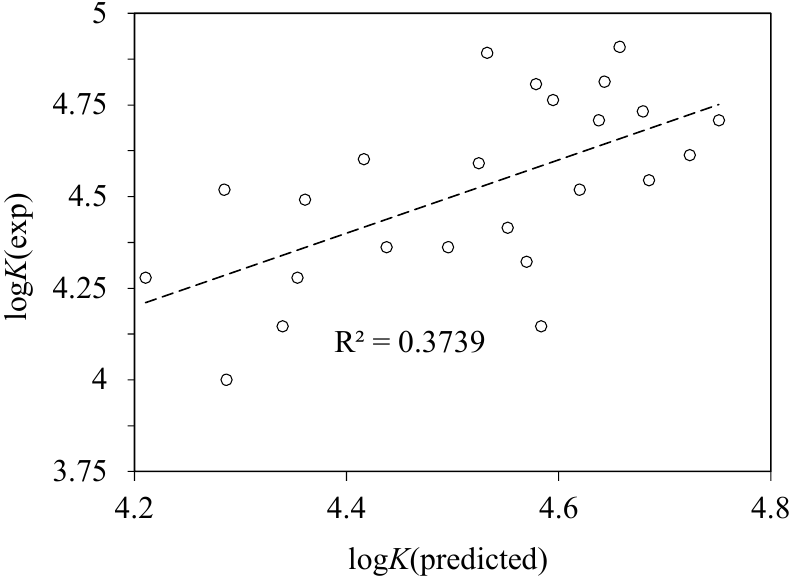
Figure 6. Plot of the experimental logarithms of binding constants log K against those predicted using a multiple linear regression with Abraham molecular descriptors E, S, A, B, and V [35].